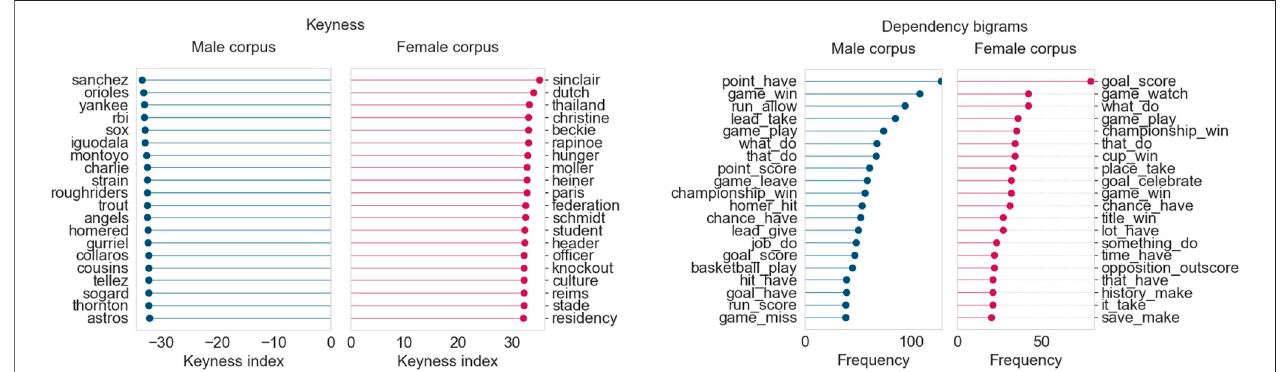
FIGURE 4 | Corpus analysis results for top 400 articles from “ Sports ” (June